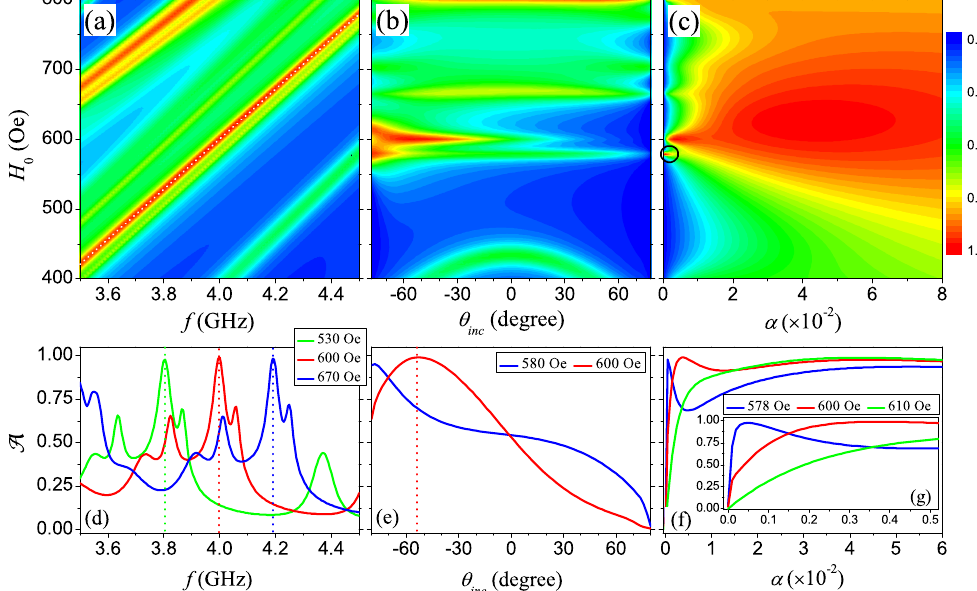
Figure 8. The tunability of nonreciprocal perfect absorption for the MM slab of type III by a BMF, shown by calculating the absorptance A as the function of BMF H 0 and working frequency f ( a ) at the specified incident angle θ inc = − 55 ◦ and fixed damping factor α = 3.5 × 10 − 3 , as the function of BMF H 0 and incident angle θ inc ( b ) for the fixed damping factor α = 3.5 × 10 − 3 and working frequency f = 4 GHz, as the function of BMF H 0 and damping factor α ( c ) for the fixed incident angle θ inc = − 55 ◦ and working frequency f = 4 GHz. To quantitatively illustrate the dependence on BMF, ( d ) the absorptance A in panel ( a ) under three different BMFs is re-plotted, ( e ) the absorptance A in panel ( b ) under two different BMFs is re-plotted, and ( f ) the absorptance A in panel ( c ) under three different BMFs is re-plotted. The inset ( g ) in panel ( f ) is the amplified view of the absorptance in the range of low damping factor. The permittivity of the DC in DCL ferrite rod is ε c = 15, the core radius is r c = 0.8 mm, and the other parameters are the same as those in Figure